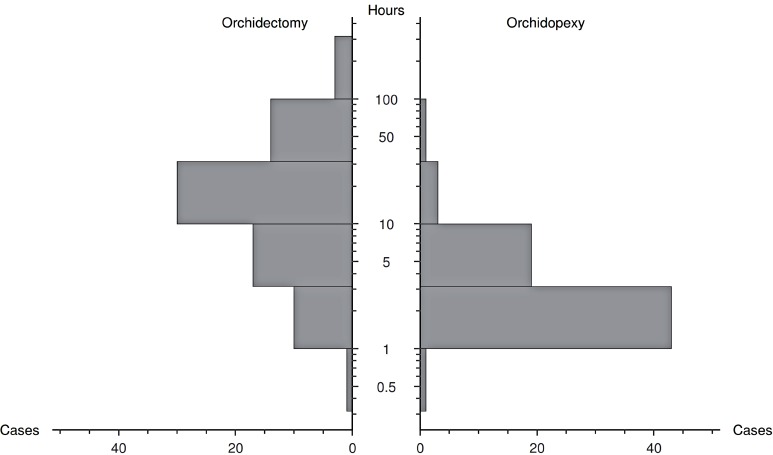
Distribution of presentation delay between patients either submitted to orchidectomy or orchidopexy.